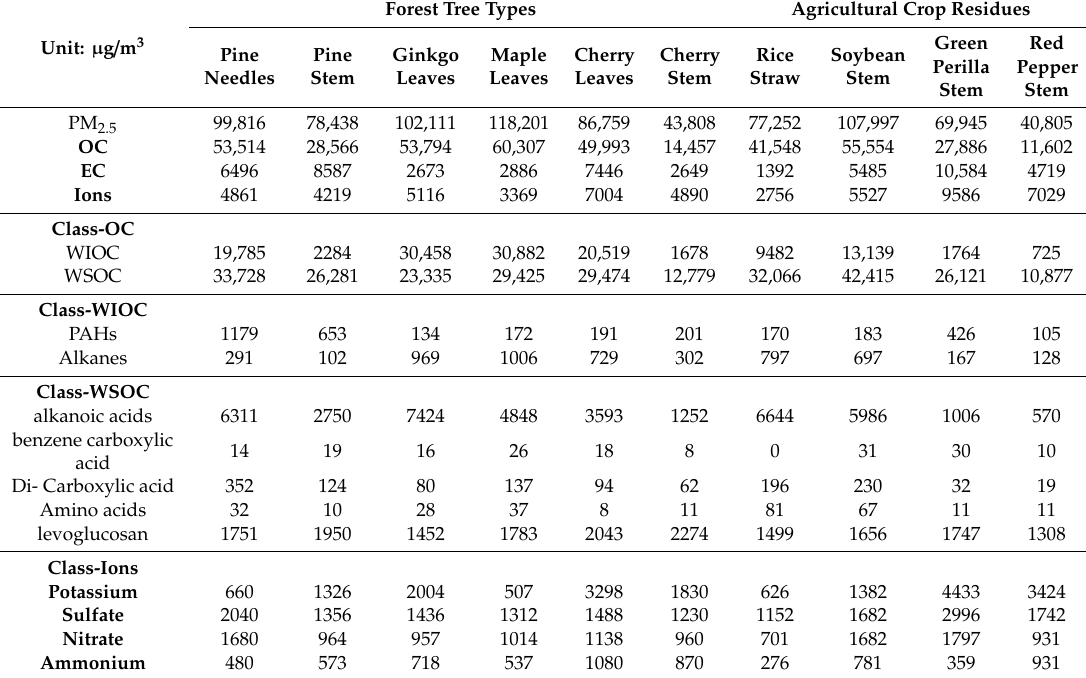
Table 2. Distribution of chemical abundances in fine particulate matter (PM 2.5 )